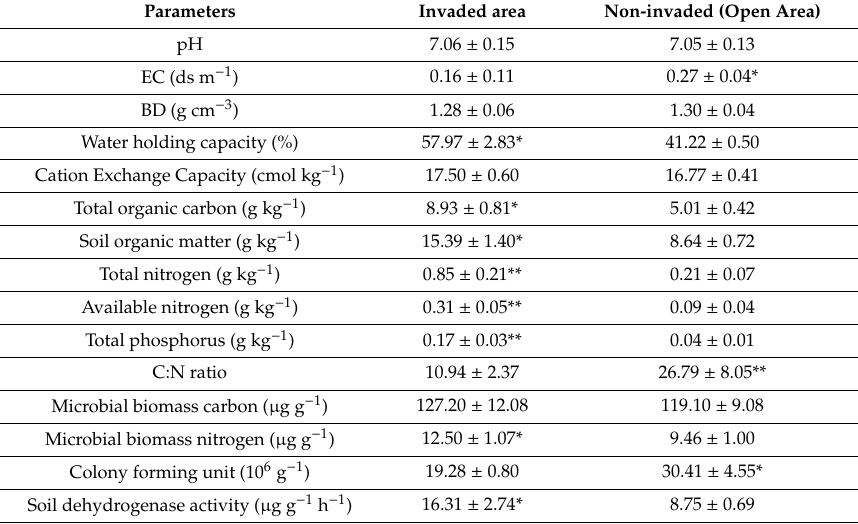
Table 3. Physico-chemical and biological properties of the soil collected from the rhizosphere of P. juliflora in the invaded area of Lucknow, India and also from the open area (n = 4; Mean ± SD) in 2015 and